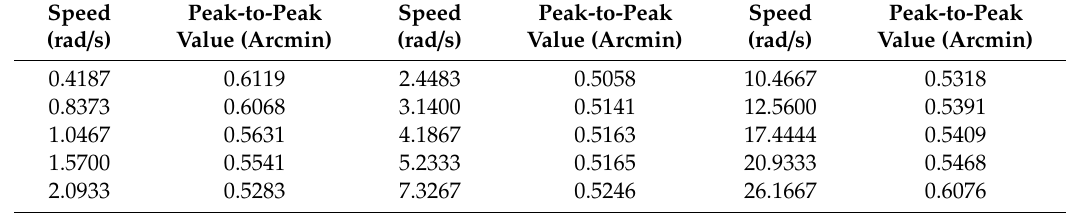
Figure 7. Transmission error curve (2.4483 rad/s).